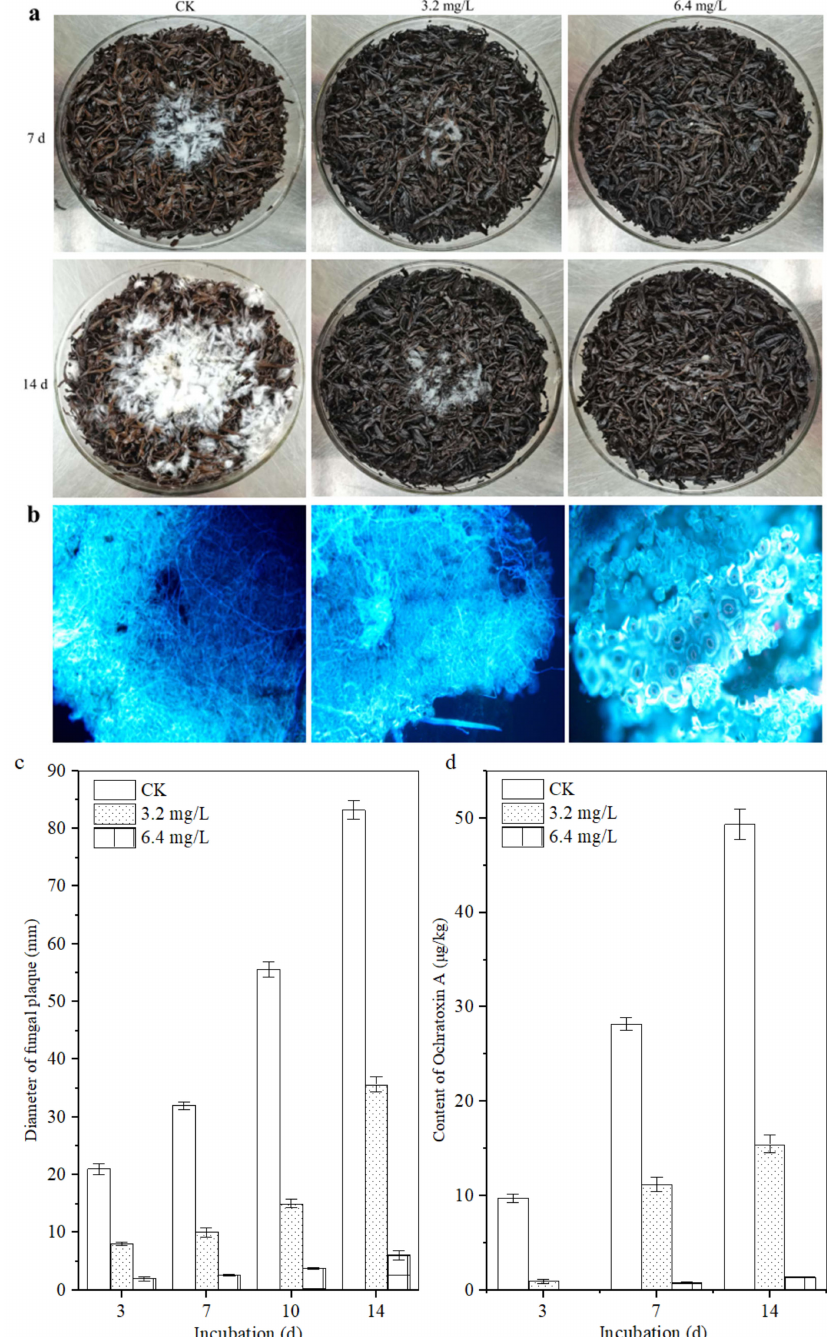
Figure 5. Inhibitory effect of polypeptides on the growth of A. carbonarius H9 on the sterilized tea. ( a ) Visible growth of A. carbonarius H9 on the tea substrate; ( b ) fluorescence microsections of tea samples treated by A. carbonarius H9 for 14 days; ( c ) the fungal plaque diameter on the tea matrix; ( d ) the inhibitory effects of crude polypeptides on OTA content in the contaminated tea samples. The fluorescence micrograph of the tea leaves inoculated with A. carbonarius H9 is shown in Figure 5b. After 14 d of incubation, as for the control group, a large amount of mycelium of A. carbonarius H9 grew inside and outside the leaf tissue. Although